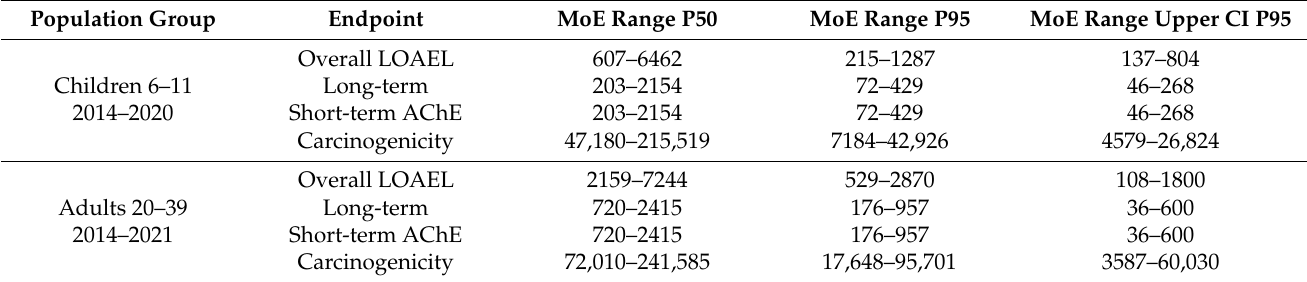
Table 3. Margins of exposure ranges for the HBM4EU-aligned studies and different endpoints. P50 represents the average population, P95 the high exposed group and upper CI P95 the most exposed individuals.